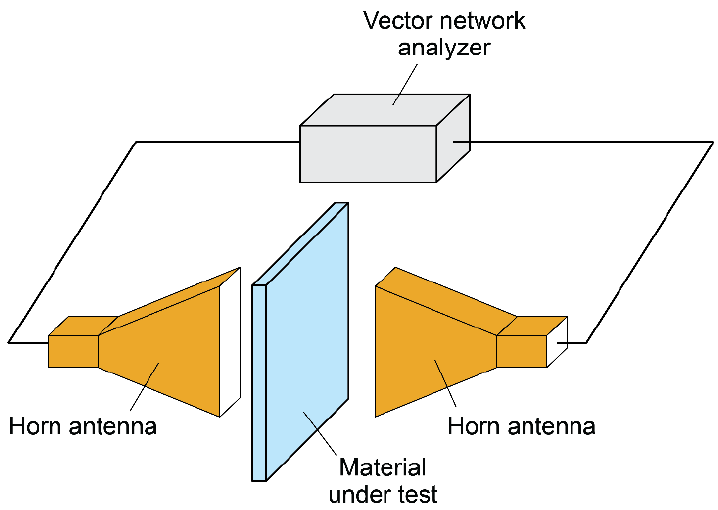
Figure 17. Schematic illustration of a free-space measurement setup with a pair of horn antennas. Redrawn from [108] (p. 102).